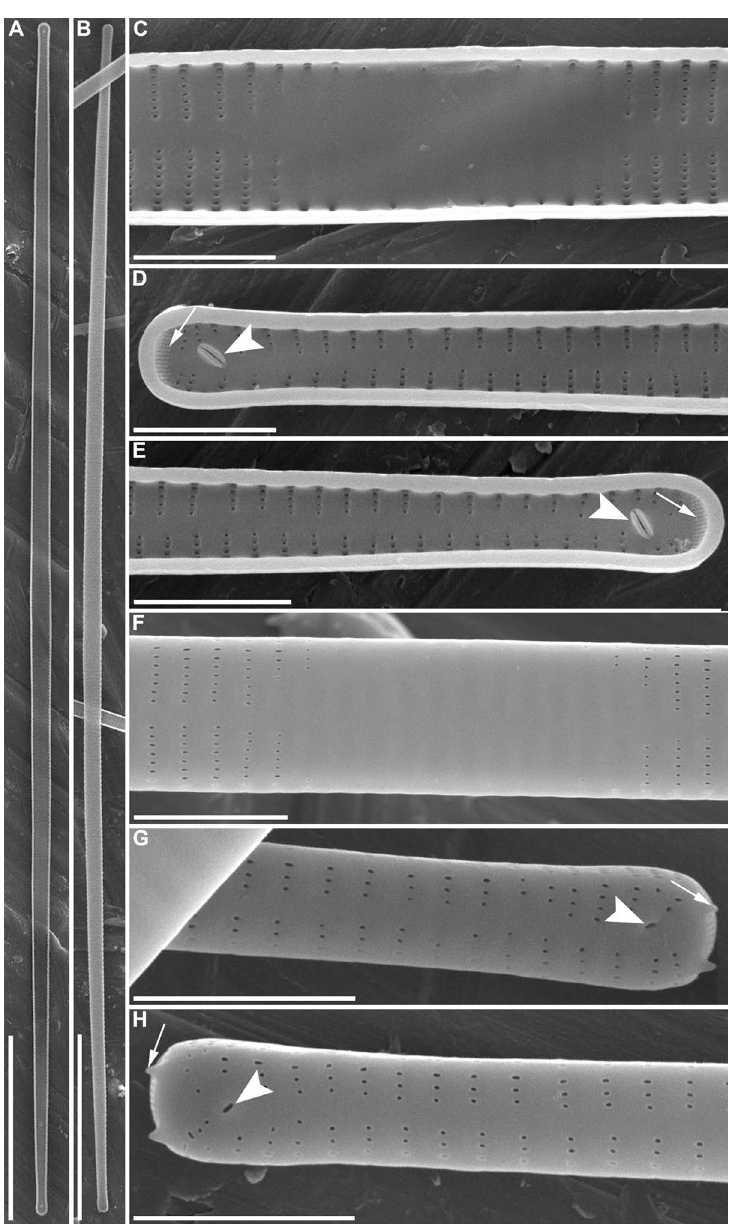
Figure 7. Valve structure of strains Uln2 group, strain BZ251. SEM. Two complete valves: ( A ) inside view; ( B ) outside view; ( C )—central area detail of ( A ); ( D , E ) apex detail of ( A ) (arrows—ocellulimbus; arrowheads—rimoprtula); ( F ) central area detail of ( B ); ( G , H ) apex detail of ( C ) (arrows—apical spines; arrowheads—holes of rimoportula). Scale bar: ( A , B )—50 μm; ( C – H )—5 μm.